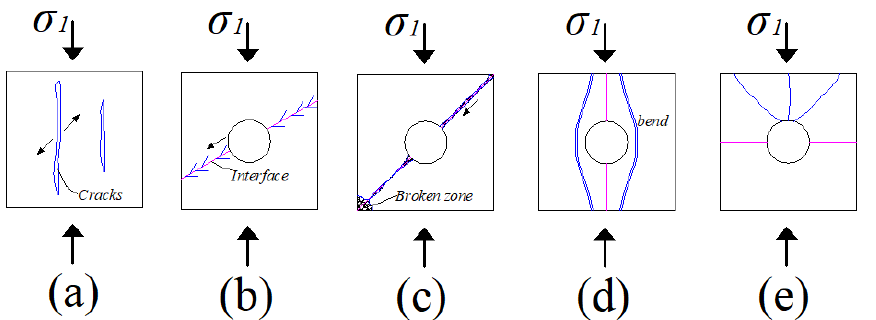
Figure 9. Diagram of failure mechanism. ( a ) is tensile failure. ( b ) is slide-shear failure. ( c ) is slide-broken failure. ( d ) is compression-bend failure. ( e ) is compression-shear failure.